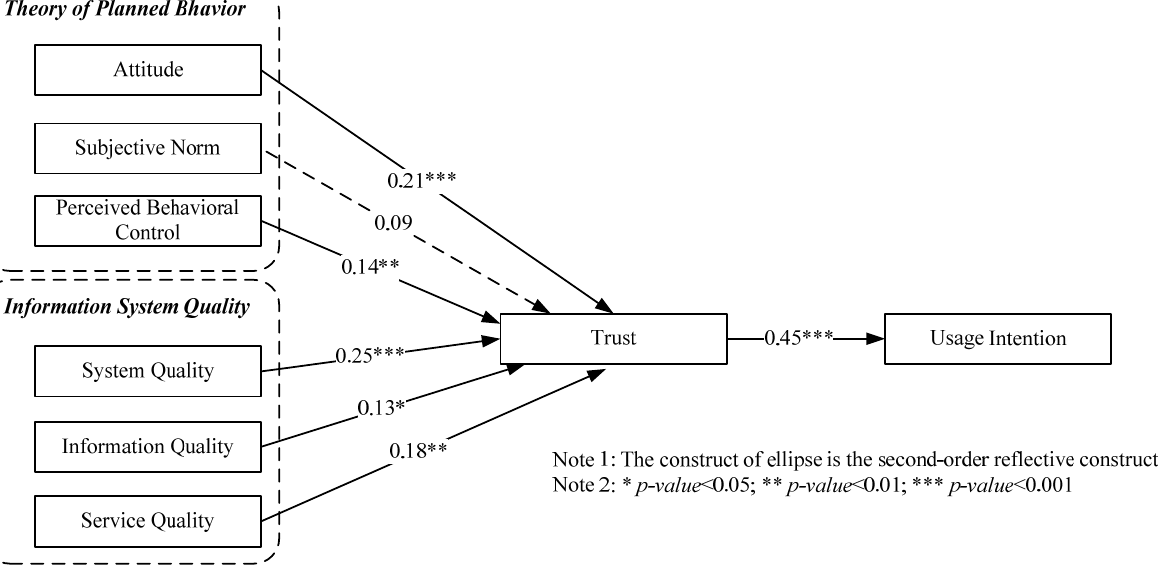
Figure 2. Path analysis of the model. Table 4. Results of hypotheses tests.